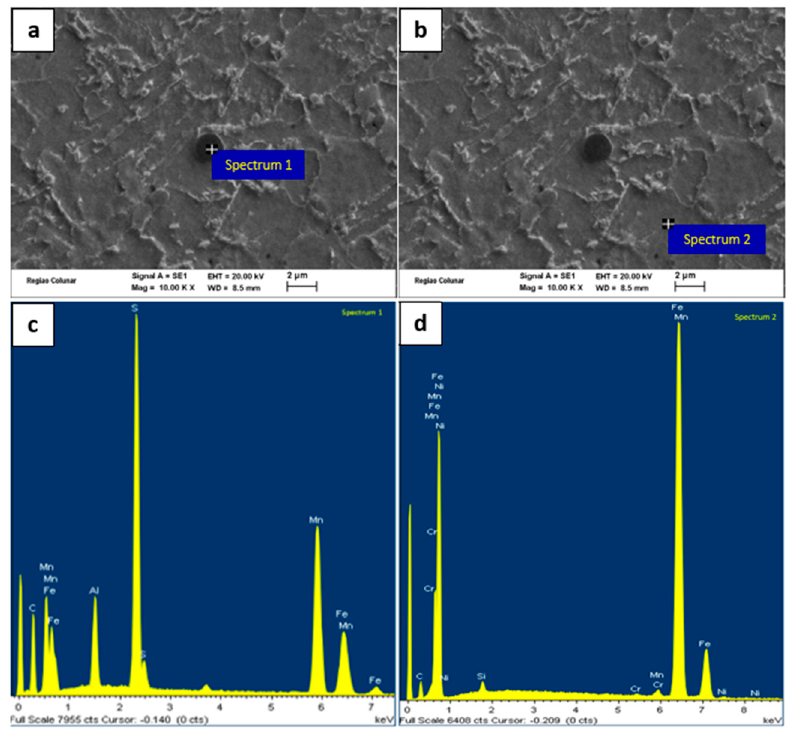
Figure 9. EDS analysis of inclusion present in the banded structure for region 2: ( a ) spectrum 1 corresponds to the analysis results shown in ( c ); ( b ) spectrum 2 corresponds to the analysis results shown in ( d ). Table 4. EDS results (weight (%)).